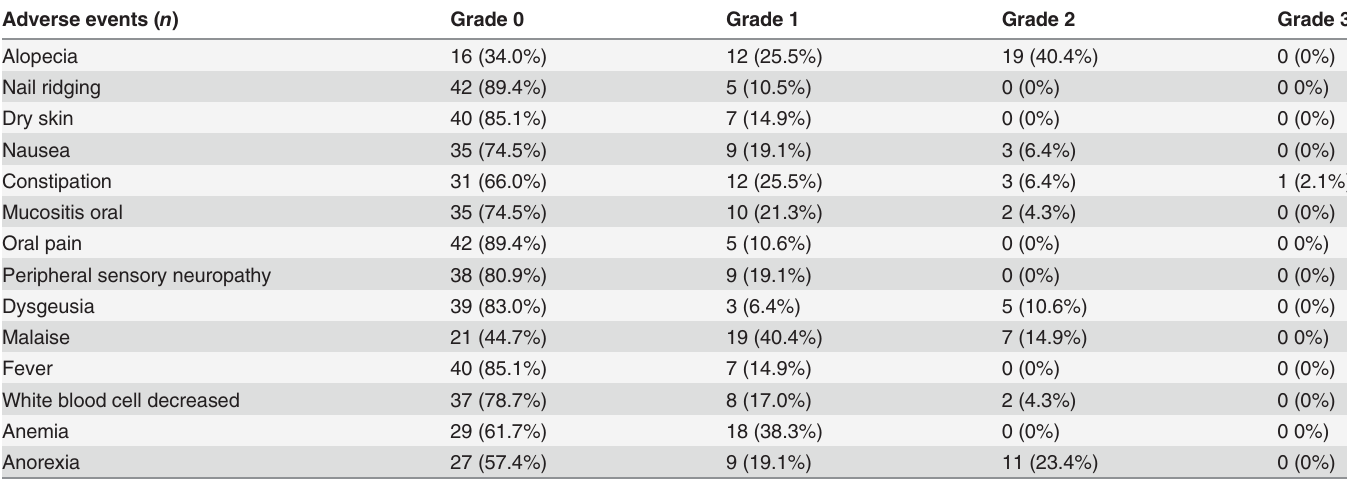
Table 4. Occurrence of individual adverse